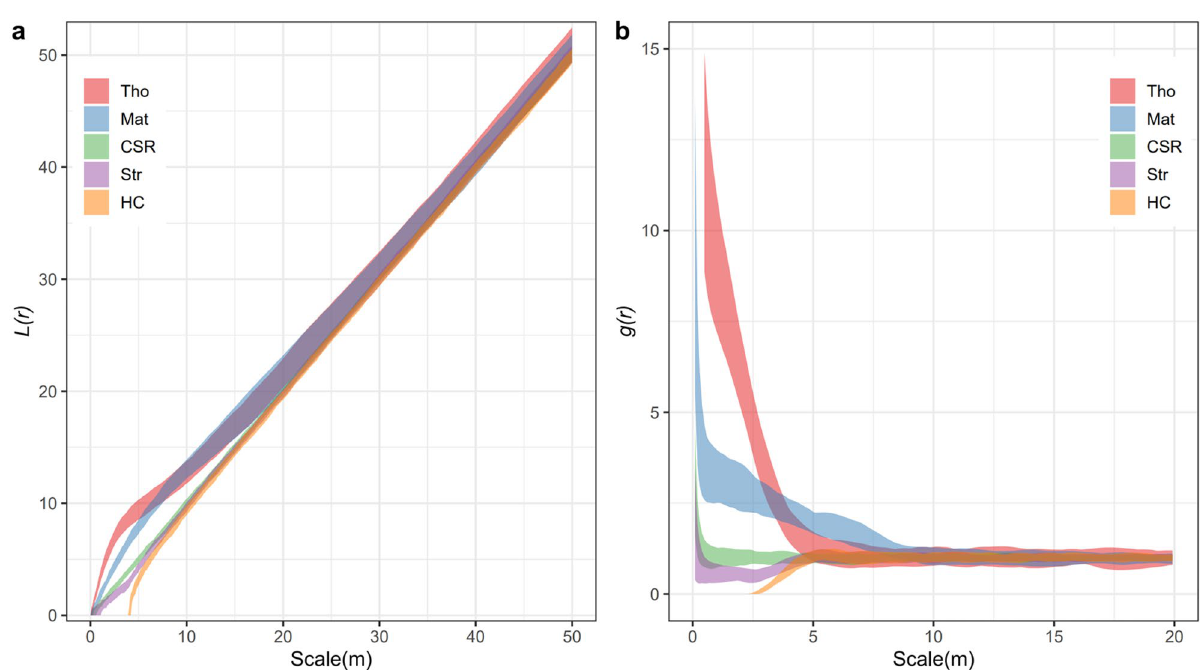
Figure 5. Variations of univariate L ( r ) and g ( r ) functions based on five spatial null models generated by 199 Monte-Carlo simulations. ( a ) L ( r ) function. ( b ) g ( r ) function. The boundary of envelopes reflects the maximum and minimum values of L ( r ) and g ( r ) functions in the simulations. The colorful areas show the 95% confidence limits around the predicted L ( r ) or g ( r ) estimated from 199 random simulations of the point